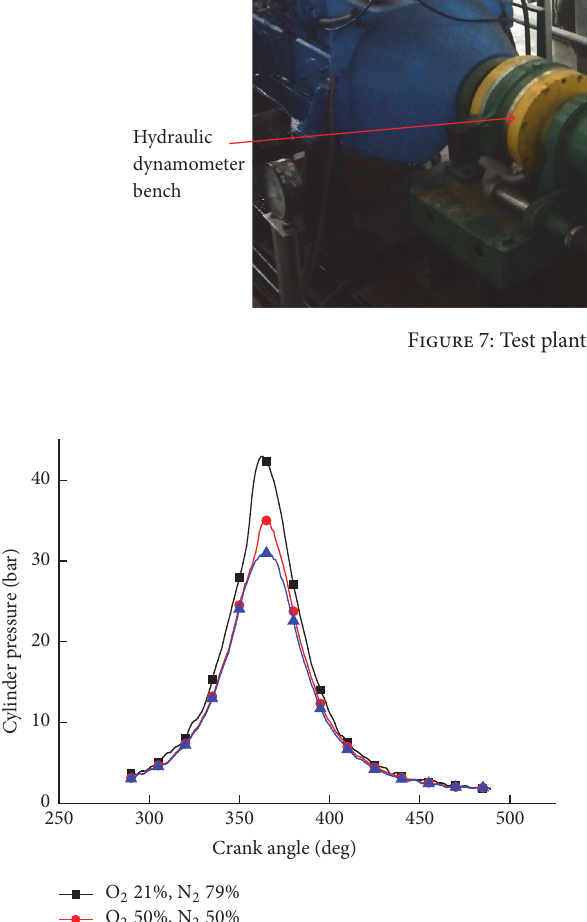
Figure8:Cylinderpressureofdieselenginetestsintheenvironment of O 2 and CO 2